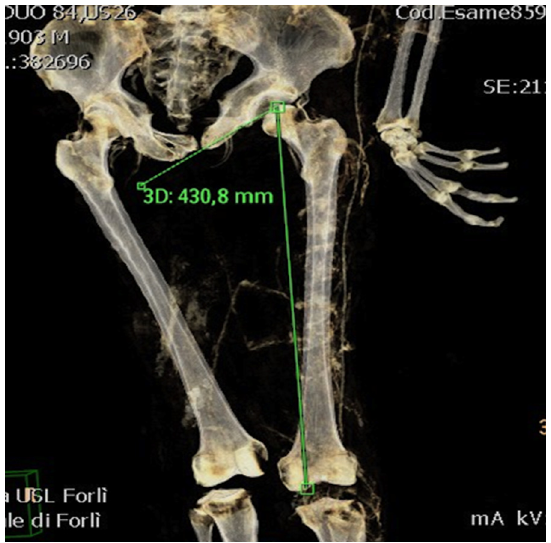
Fig 3. Measurement of left femur for anthropometric calculation of